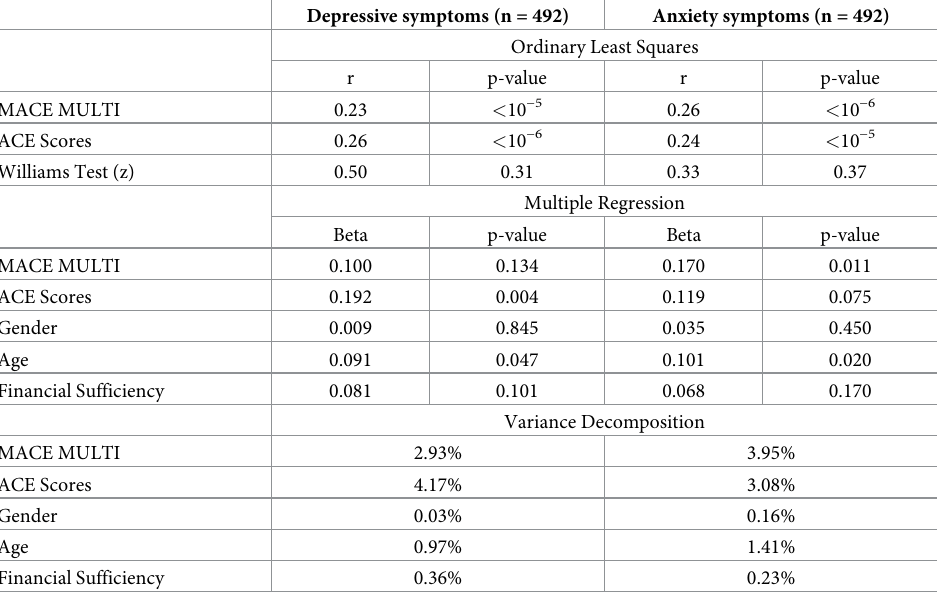
Table 15. Comparative difference between MACE MULTI and ACE